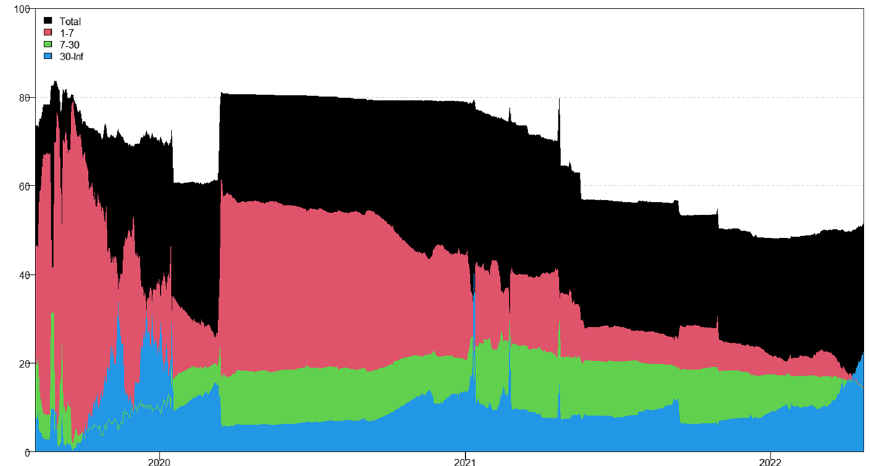
Fig. 22 Dynamic total connectedness—realized positive semivariance